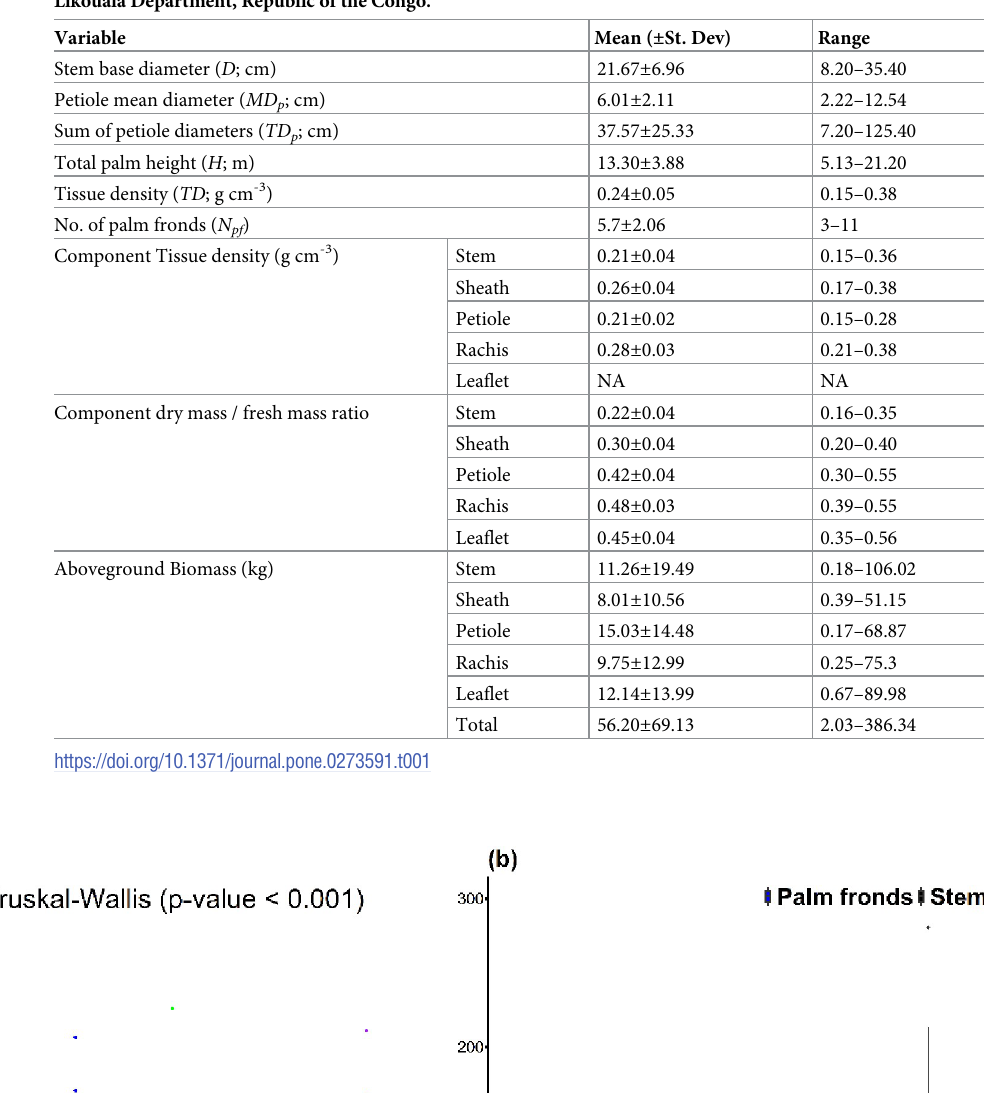
Table 1. Physical characteristics of the 90 R . laurentii individuals destructively sampled in the peat swamp forest, Likouala Department, Republic of the Congo.